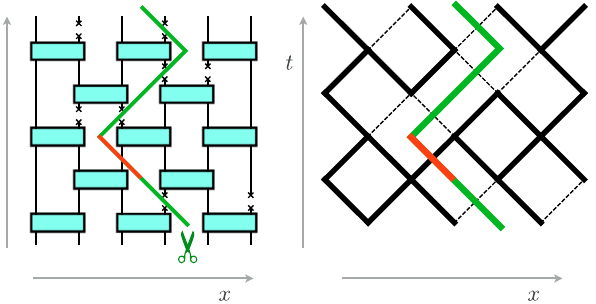
FIG. 4. Mapping between circuit dynamics with measurement (left panel) and bond percolation on the square lattice (right panel). For the purposes of the minimal-cut picture, a projective measurement breaks a bond. The minimal cut may pass through broken bonds at zero cost. For the figure on the right, which is topologically equivalent to the one on the left, we represent each unitary as the vertex of a square lattice. Broken bonds are dashed (unoccupied), and unbroken bonds are solid (occupied). This configuration corresponds to bond percolation on the square lattice, with a probability 1 − p for a bond to be occupied. The minimal cut lives on the dual